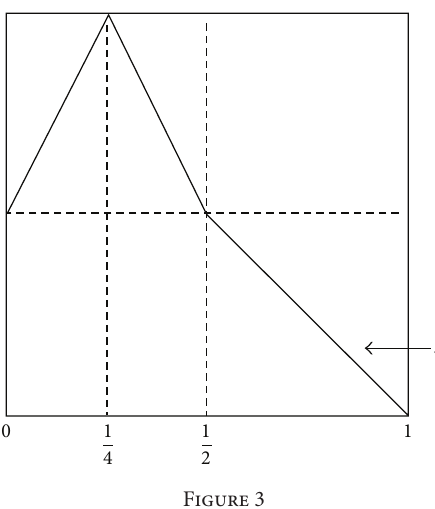
1 . Moreover, by Jacobi’s